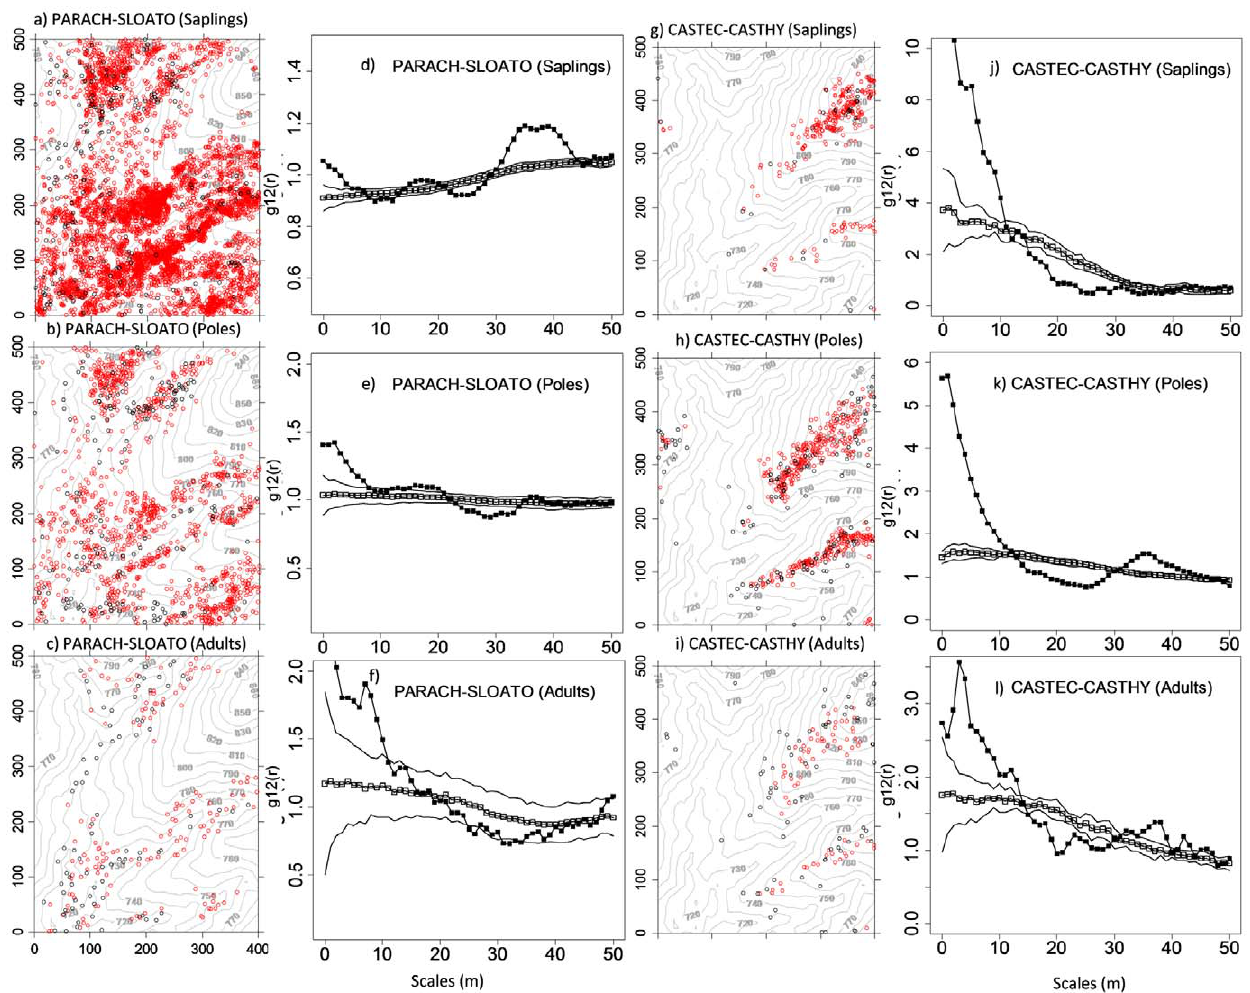
Figure 3. Examples of species associations in bivariate patterns. Shown are the bivariate g 12 pair-correlation functions of the data in dependence on scale r (solid squares), the expected g 12 (r) function under the heterogeneous Poisson null model (open squares) and the simulation envelopes (solid lines) of the Monte Carlo simulations of the null model. Monte Carlo confidence was constructed at approximately 95% confidence level (199 simulations). See Table 1 for species codes. Red open circle is the first species, and black solid circle is the second species.